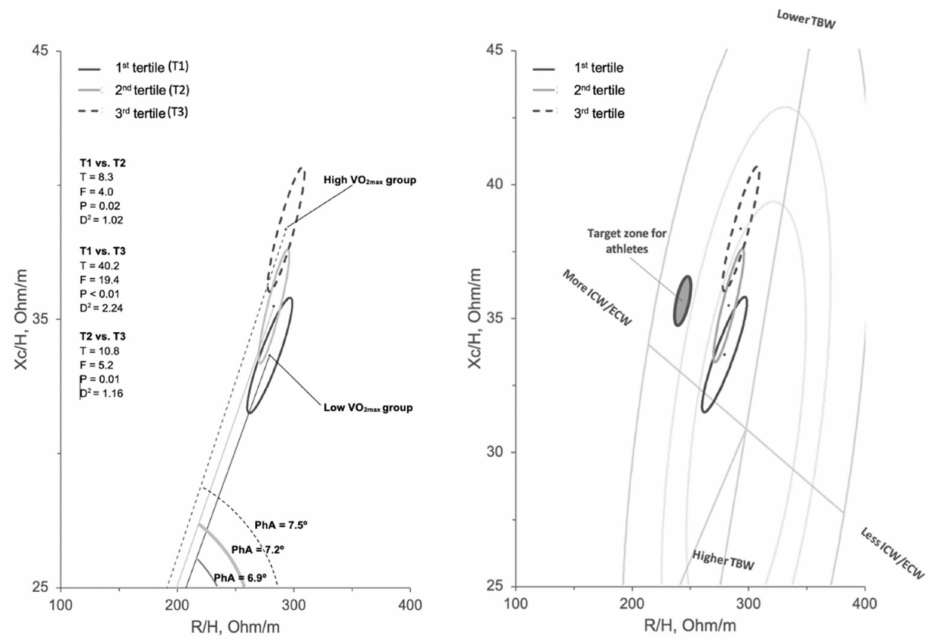
Figure 3. On the left, mean impedance vectors with their 95% confidence ellipses for VO 2max tertiles and Hotelling’s T 2 test results; vector direction defined by phase angle (PhA) is also shown. On the right side, the target zone for athletes [26] is reported and the tolerance ellipses for the general population [27] depicted in the background.